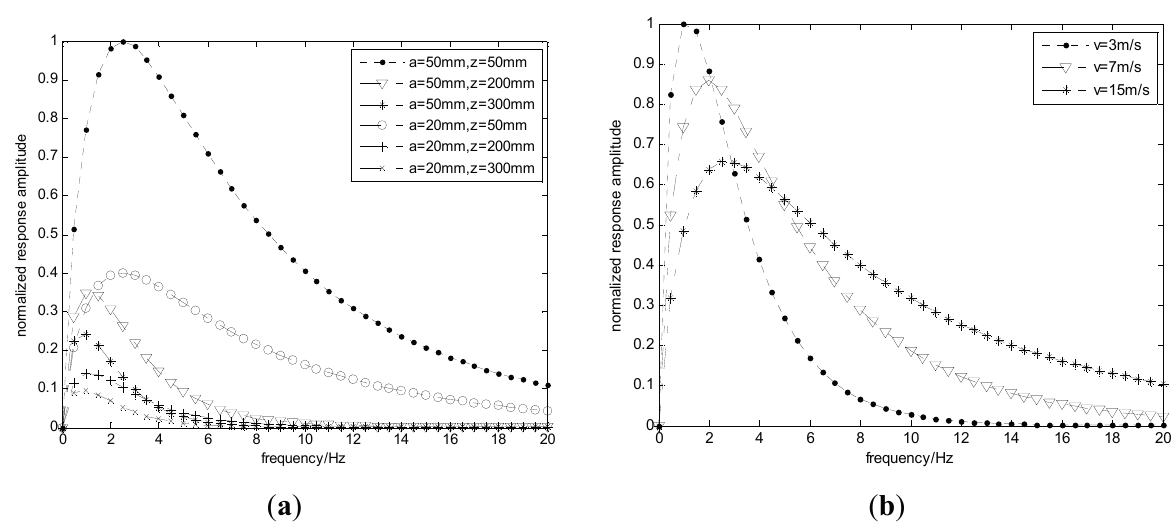
Figure 10. System frequency responses for different radii ( a ) and ν ( b ).